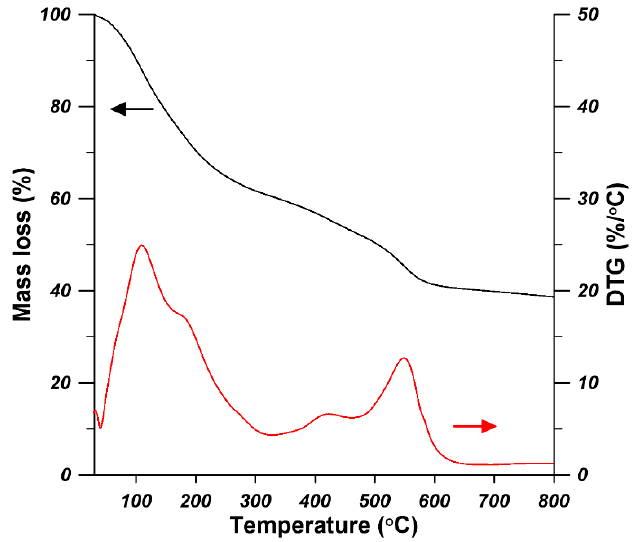
Figure 4. TGA (thermal gravimetric analysis) curves of UiO-66-NH 2 .